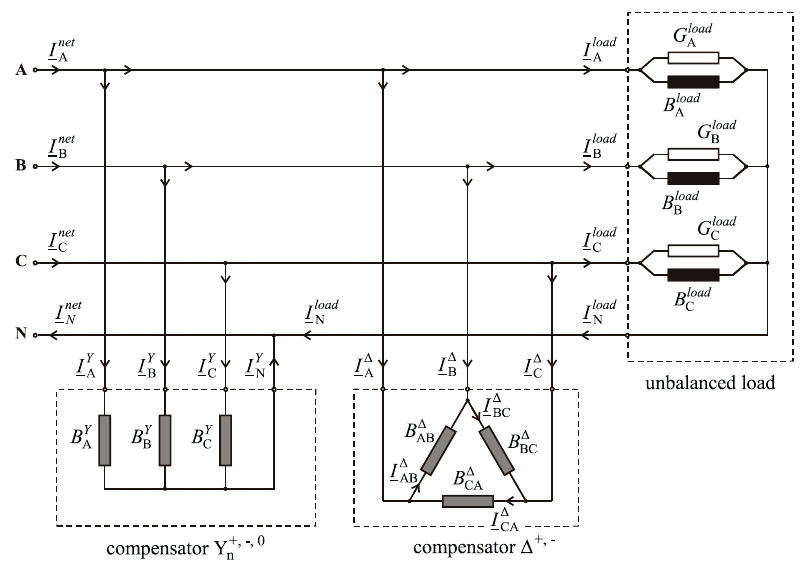
Figure 1. The equivalent schema of an unbalanced load and of the Balancing Reactive Compensator. As a result of the Adaptive Balancing Compensator (ABC) action, the load-compensator assembly is seen from the network as a perfectly balanced equivalent load, which consumes only active power [16,26,28]. For the sizing of the six susceptances of the compensator, the analytical expressions are determined applying the conditions of simultaneous cancellation of the symmetrical current components with negative effects on the phases of the load-compensator assembly: the imaginary (reactive) component of the positive sequence current, the real and imaginary components of the negative and zero sequence current components [9]: